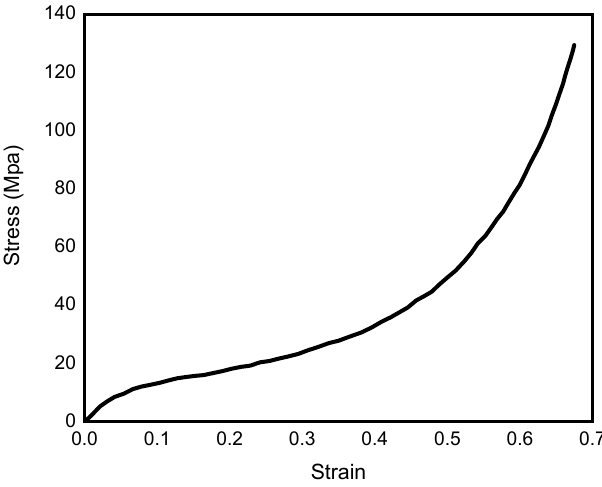
Figure 3. Foam aluminum constitutive curve.